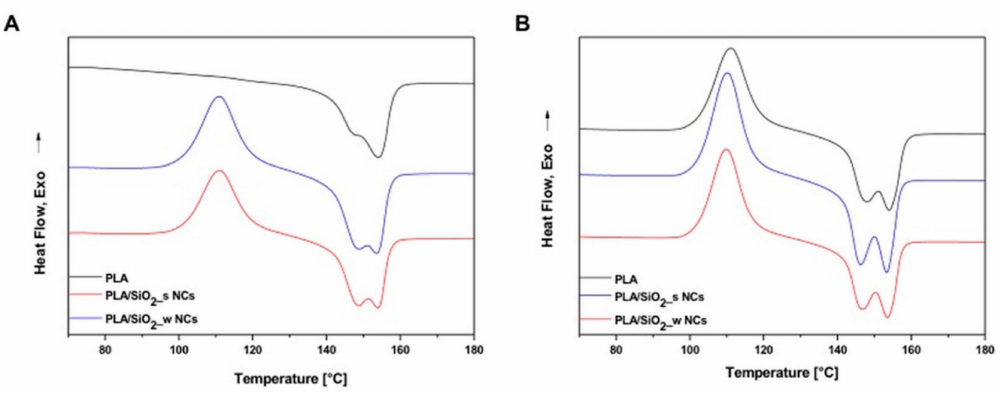
Figure 6. DSC curves of the first ( A ) and second ( B ) heating of pure PLA and PLA / SiO 2_ s and PLA / SiO 2_ w nanocomposites.